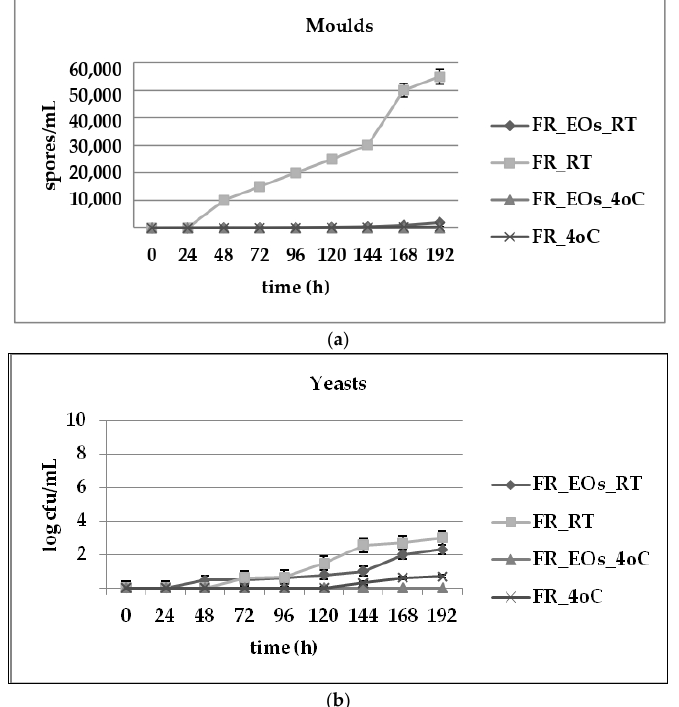
Figure 2. Spoilage of fruit juices (FR) supplemented with P. lentiscus and F. margarita EOs ( a ) from molds, ( b ) yeasts, during storage at room temperature (RT) and at 4 °C. Fruit juices with no EOs served as controls.